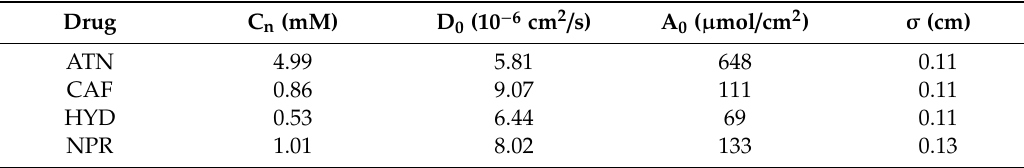
Figure 1. Di ff usion profiles of ca ff eine (CAF) in water ( A ), MUC 0.1 ( B ), 0.3 ( C ), and 0.6% ( D ) ( w / w ). Absorbance recording point was fixed at 0.51 cm from the origin of the di ff usion. Table 2. Analytical parameters obtained from Equation (1). C n expresses the nominal initial concentration in the donor, D 0 the di ff usion coe ffi cient in plain water, A 0 the initial amount injected and σ the width of the initial distribution of the tested drug (ATN, CAF, HYD, and NPR). Data reported are the average of two parallel experiments (variation below 5% and fitting error below